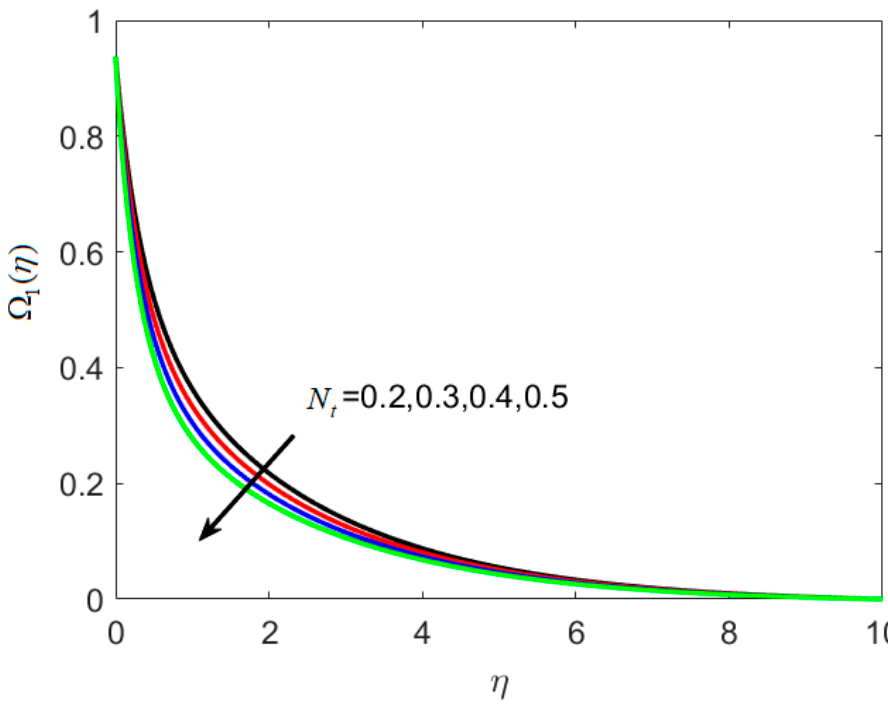
Figure 6. Various estimates of thermophoretic parameter N t by taking B 1 = 1.3, B 2 = 1.2, S t = 0.3, λ h = 0.1, N c = 0.3, γ = 0.2, κ ∗ = 0.1, Le = 0.2, δ =